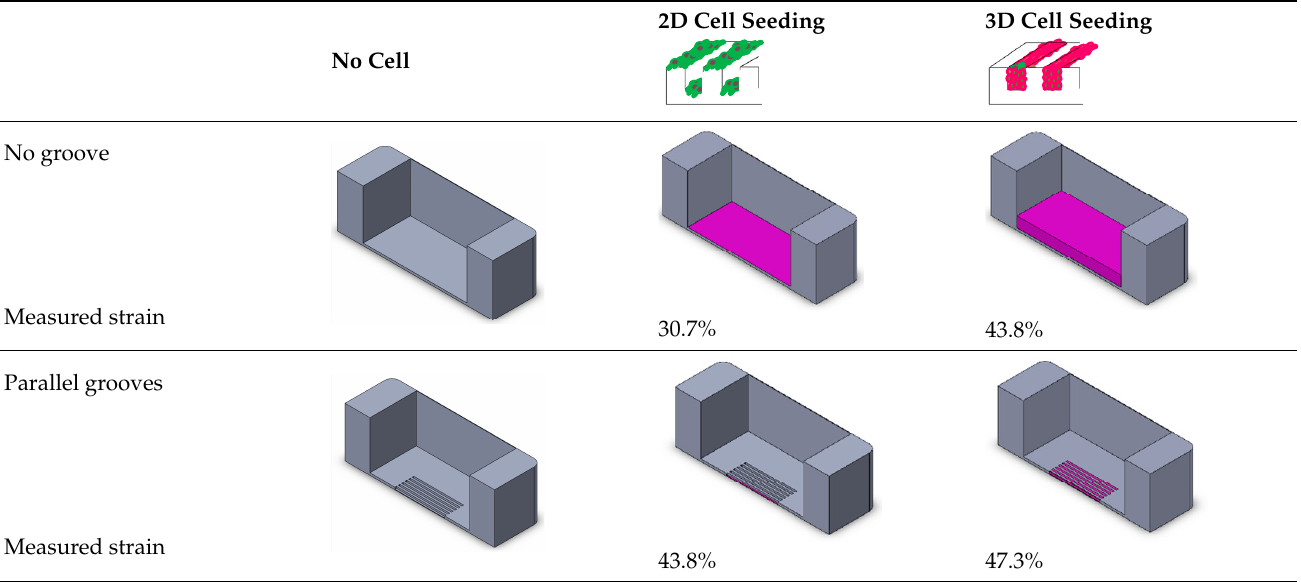
Table 2. PDMS chamber dimensions . Chamber length